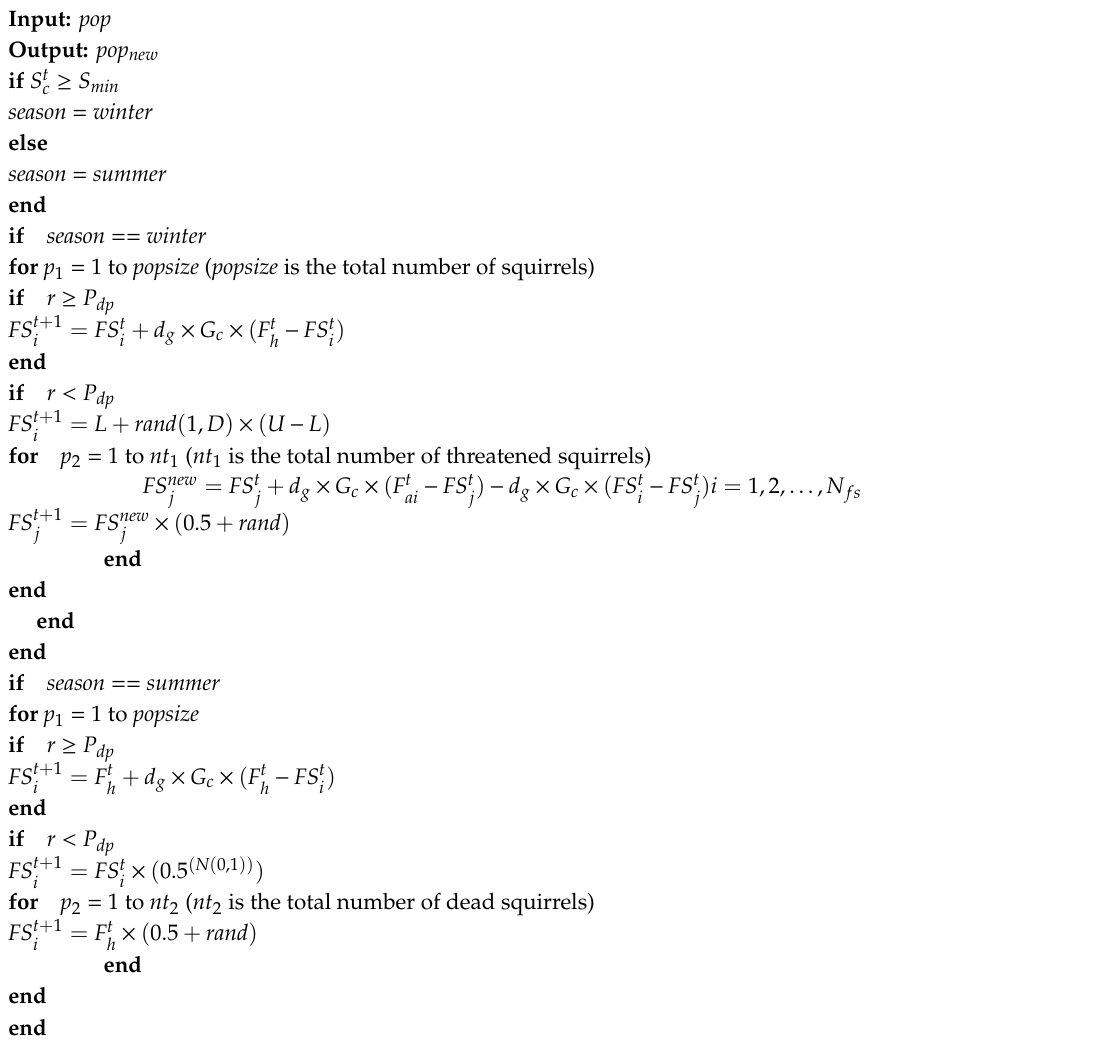
Algorithm 2. Pseudo Code of the Jumping Search